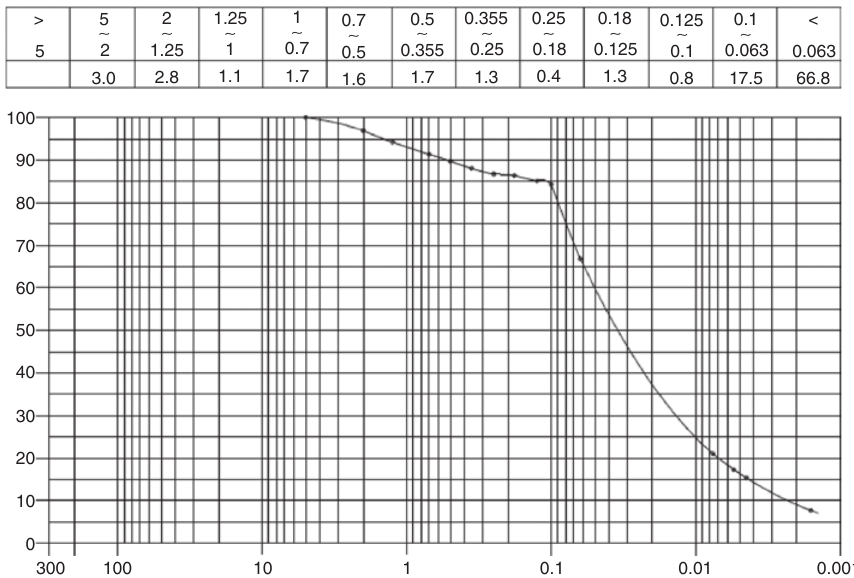
Figure 4: Particle size distribution of Pb (polluted